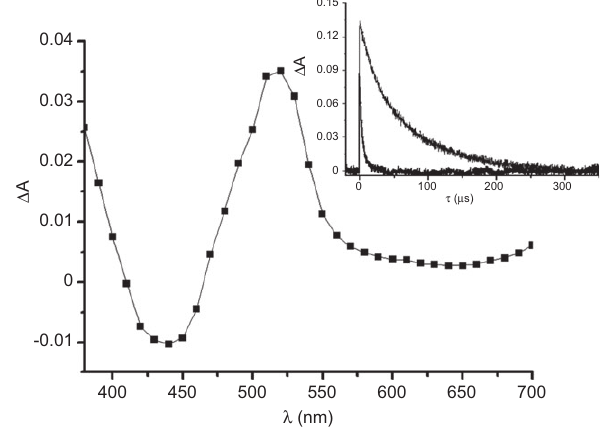
2 + solution in 3